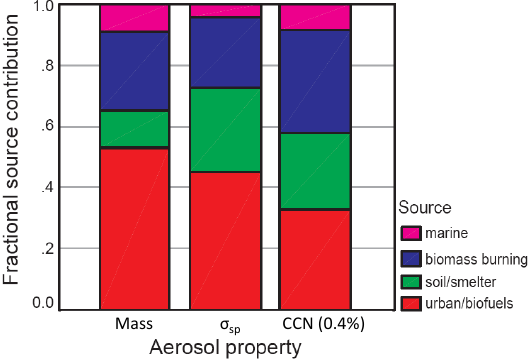
Fig. 8. Fractional contribution of each source to each of the three aerosol properties examined.